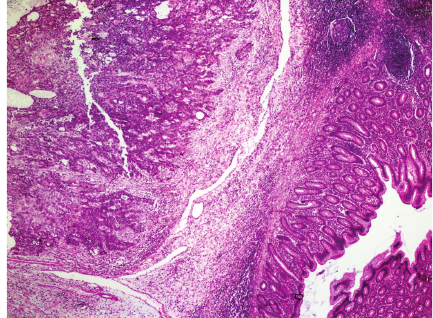
Figure 1: The cyst wall was thickened with a firm mass.